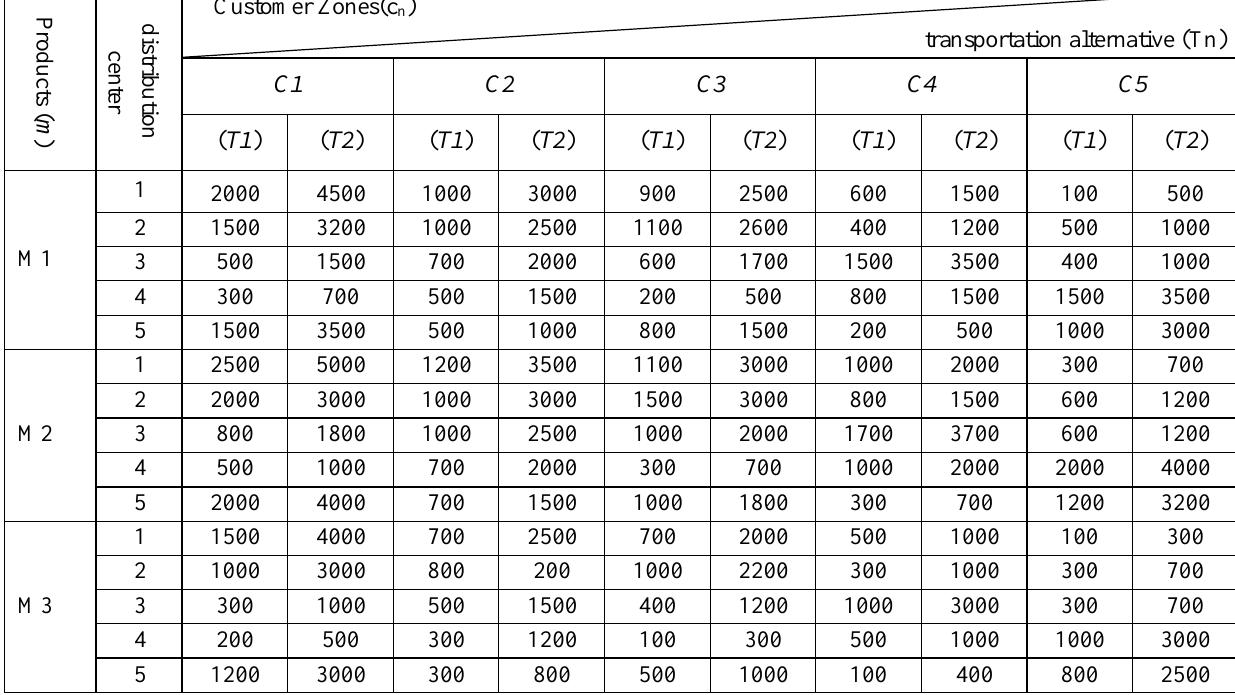
Table 4 - The transportation costs of products from distribution center (TC dcmt ) to customer zones by